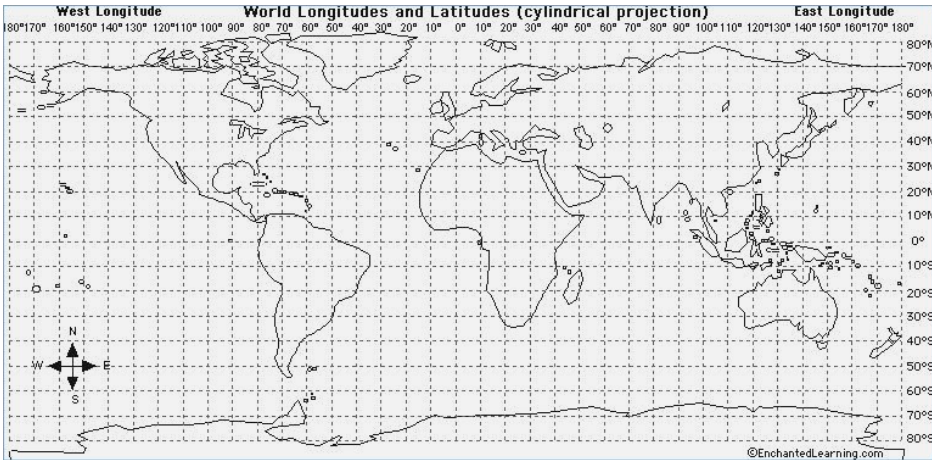
Figure 10. World longitudes and latitudes (cylindrical projection) [38].